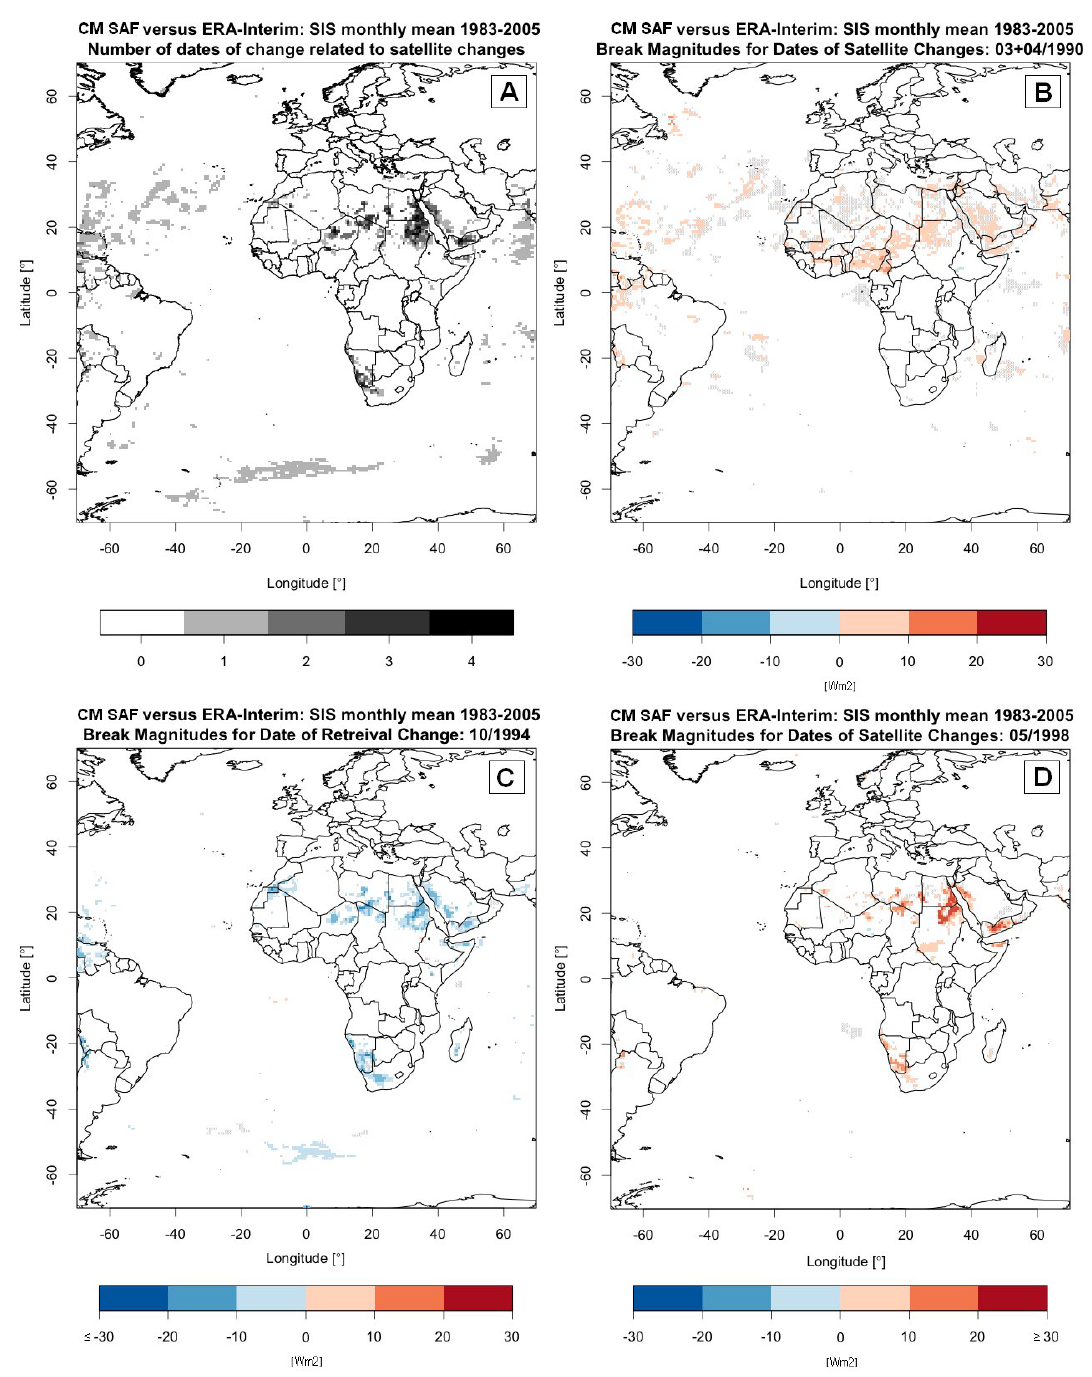
Figure 11. Relative analysis of CM SAF SIS versus ERA-Interim SIS with detrending. ( A ) Number of breaks consistent with dates of satellite or retrieval changes at individual grid points and break magnitudes for ( B ) 03/1990 + 04/1990, ( C ) 10/1994 and ( D ) 05/1998. Grey shaded areas illustrate regions with inhomogeneities only in the case of an analysis without